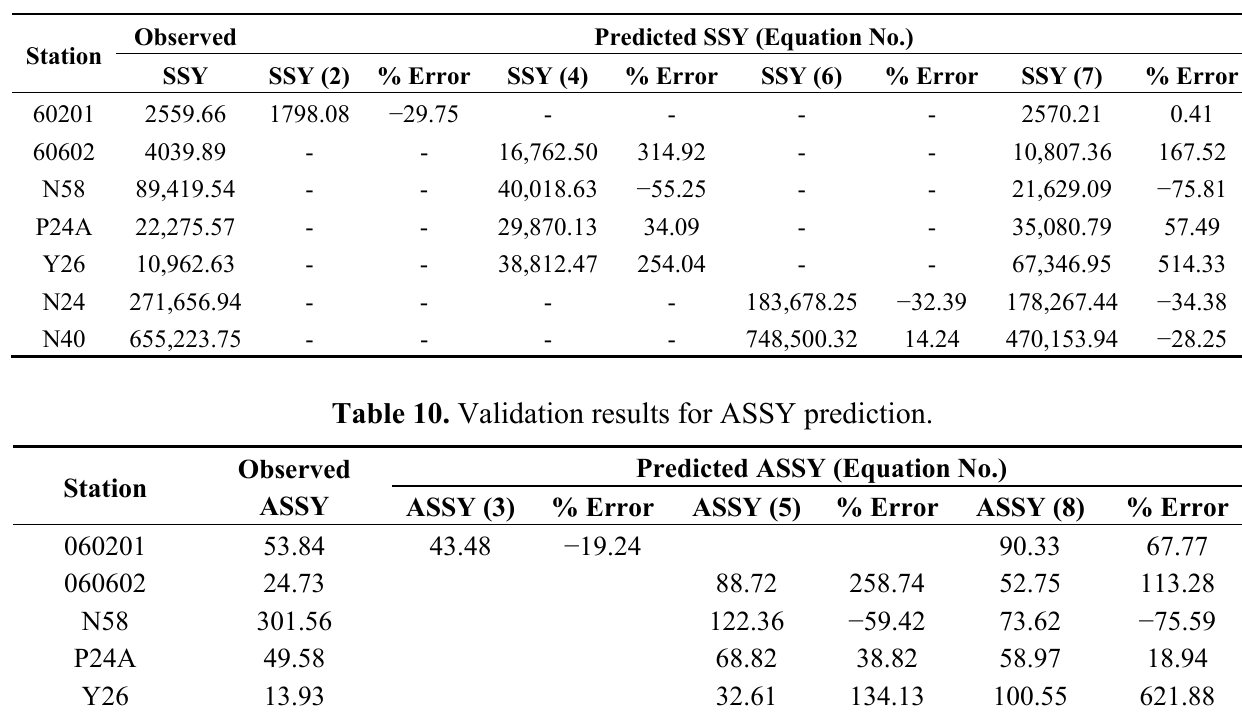
Table 9. Validation results for SSY prediction.